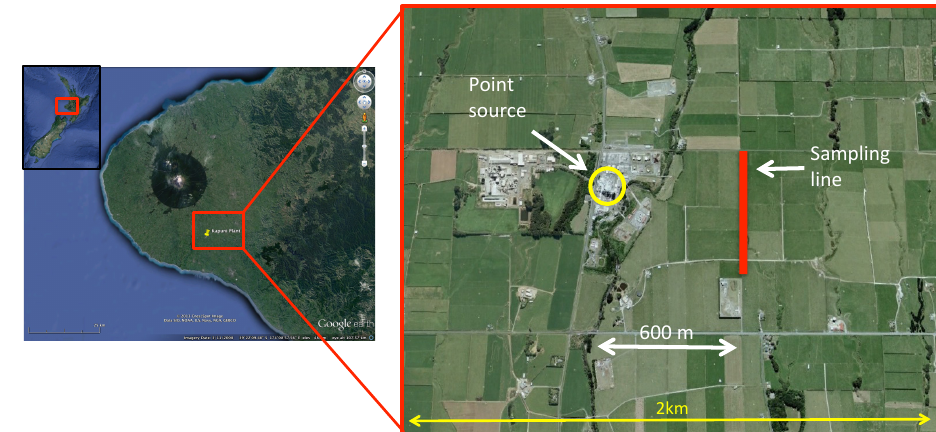
Figure 1. Map showing location of Kapuni processing plant and kite sampling